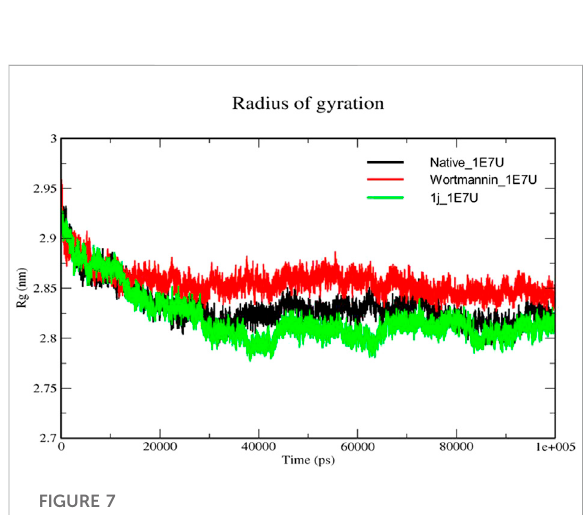
FIGURE 7 Radius of gyration analysis for the native structure of 1E7U (black) and its complexes with Wortmannin (red) and 1j (green).